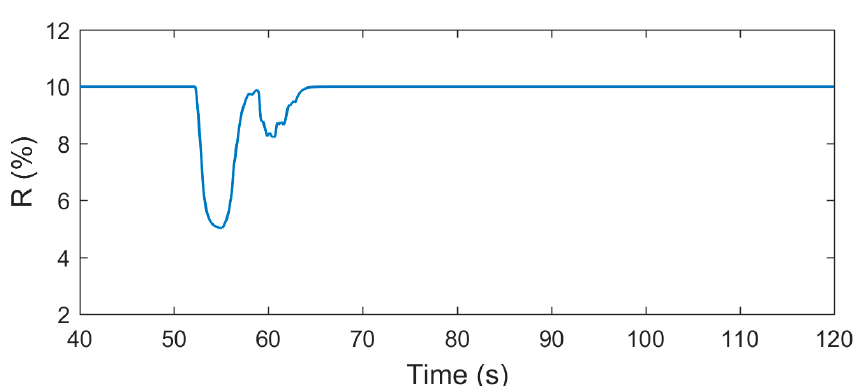
Figure 13. Dynamic droop (small ROCOF).